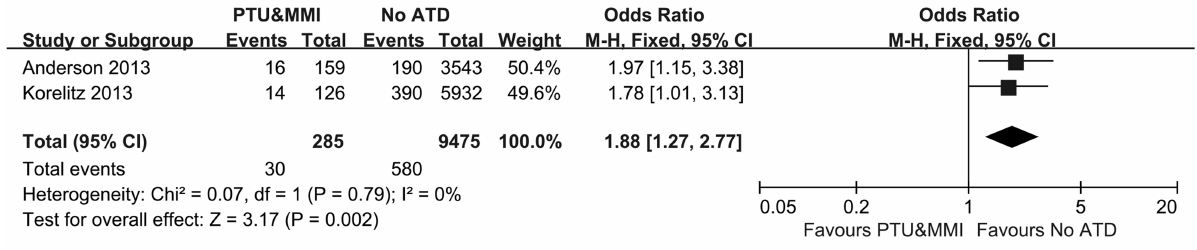
Figure 4 - Forest plot of the odds ratios and 95% confidence intervals of the pooled studies comparing pregnant hyperthyroid women who shifted between PTU and MMI with pregnant hyperthyroid women who did not receive any ATD treatment according to the risk of congenital